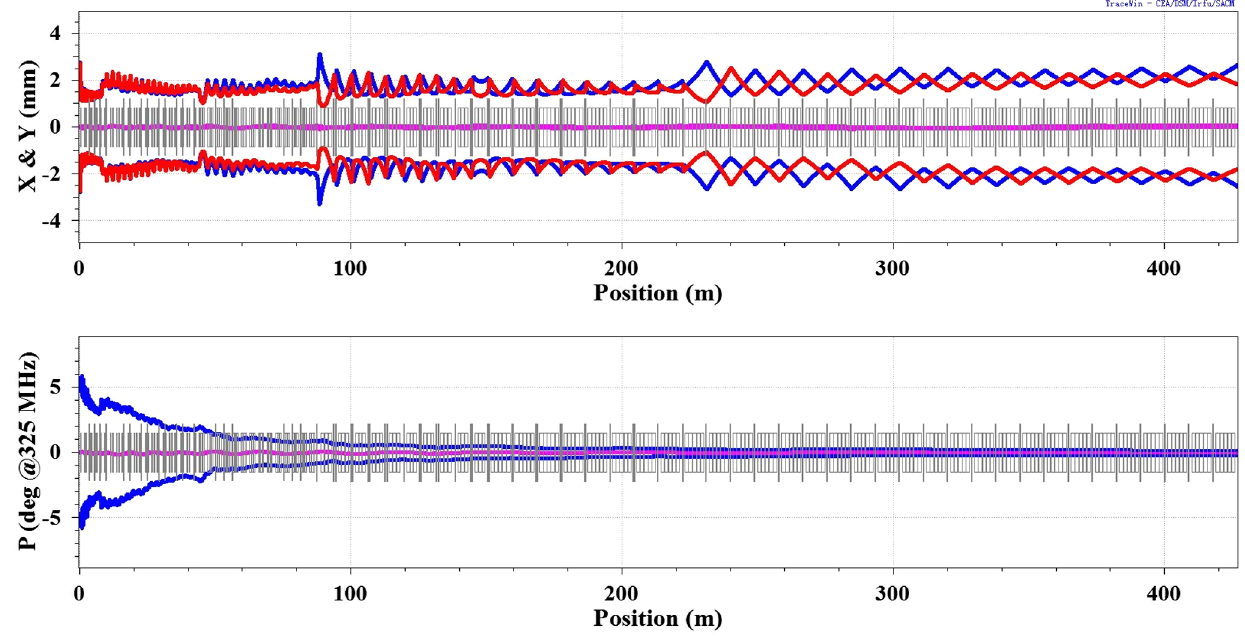
FIG. 6. The rms beam envelopes along the linac.